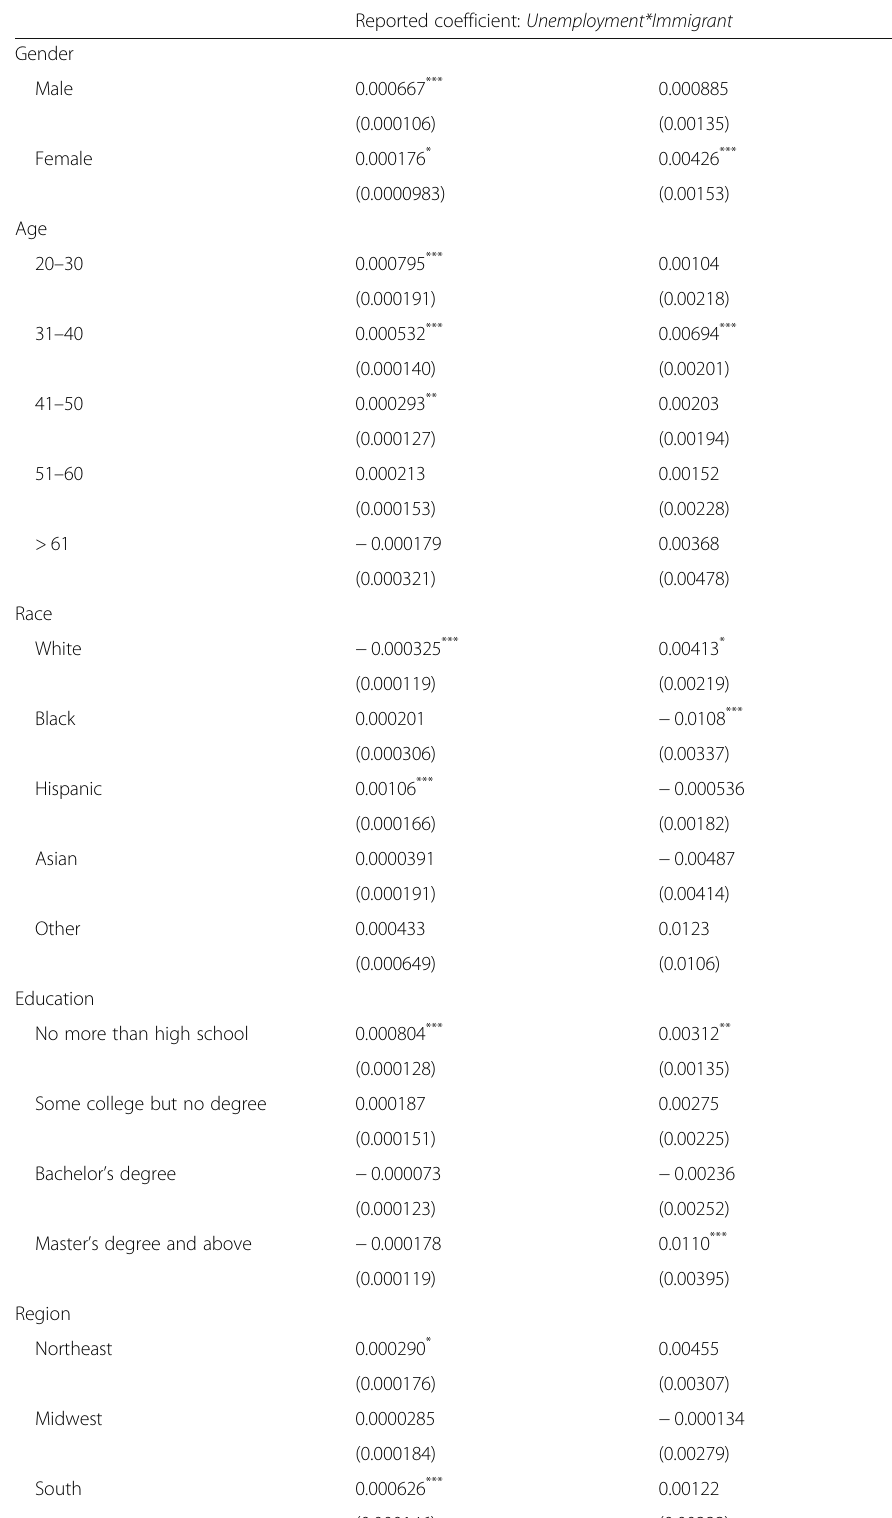
Table 8 Test for heterogeneity based on two-way transitions: matched CPS data, 1996 –